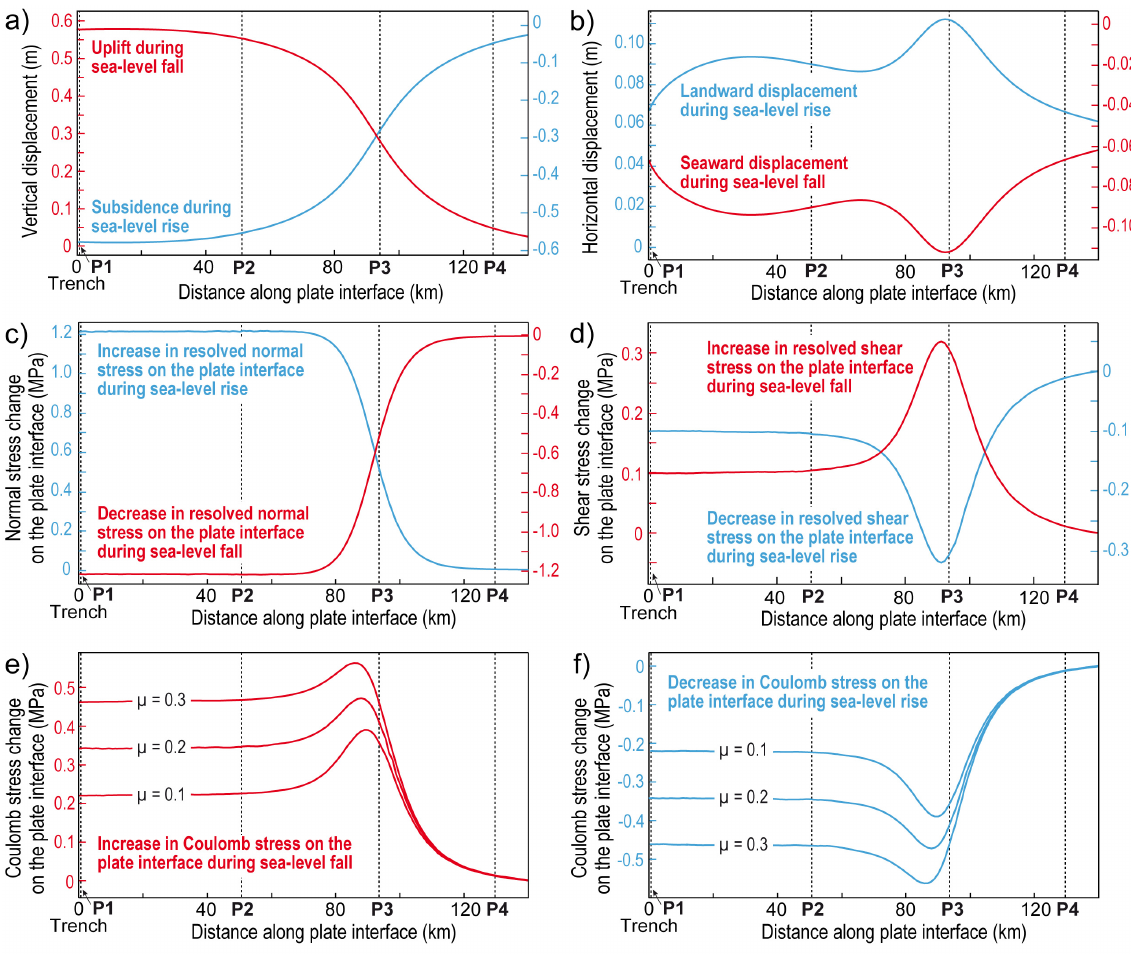
Fig. 6. Profiles along the plate interface showing displacement and stress changes induced by sea-level fall (red curves and scales) and sea-level rise (blue curves and scales). (a) Vertical displacement, (b) horizontal displacement, (c) resolved normal stress on plate interface and (d) resolved shear stress on plate interface. Changes in the Coulomb stress (e) during sea-level fall and (f) during sea-level rise were calculated using different values (0.1, 0.2 and 0.3) for the friction coefficient µ. For location of points P1–P4 see Fig.